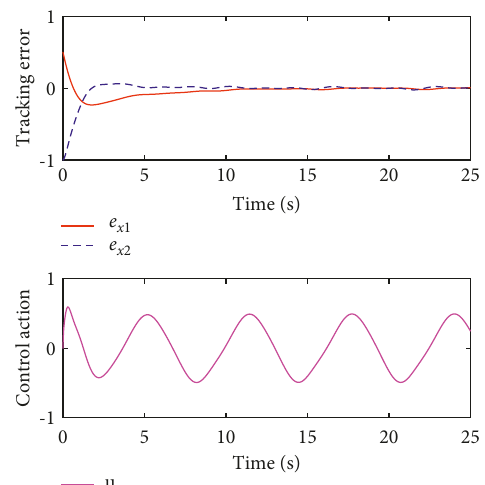
Figure 3: Tracking error and proposed control action with (34).